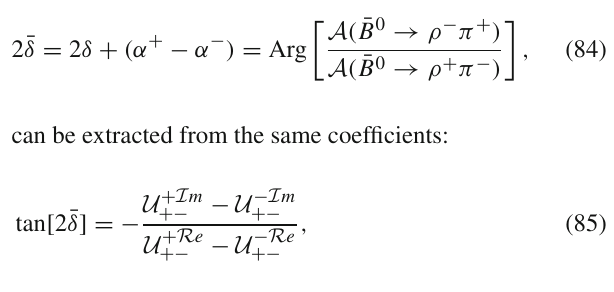
( α eff , δ eff ) plane using either subset of observables. Clearly, only the solutions for α eff near 45 ◦ are favoured by